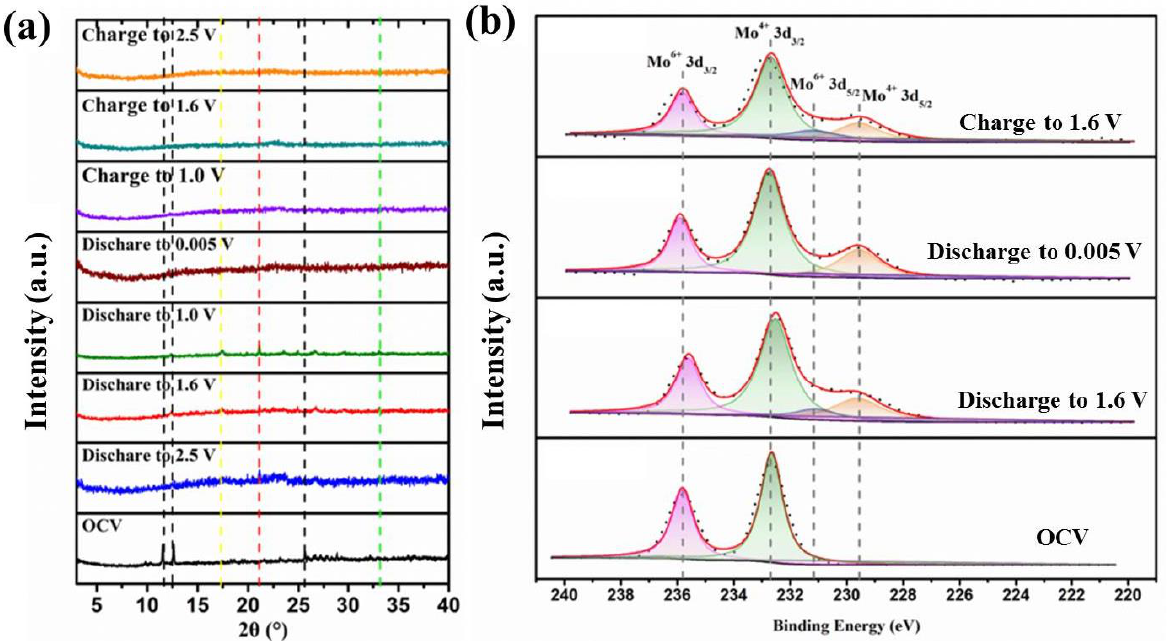
Figure 4. ( a ) E x -situ XRD patterns of the AMT/PDA electrode with different charge-discharge state, ( b ) E x -situ XPS spectrums of Mo 3d for the AMT/PDA electrode with different charge-discharge state